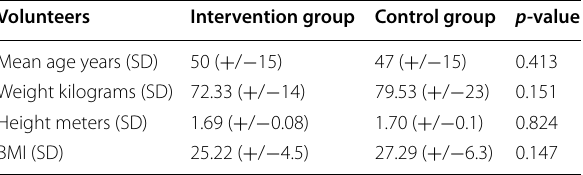
BMI: body mass index; SD: standard deviation